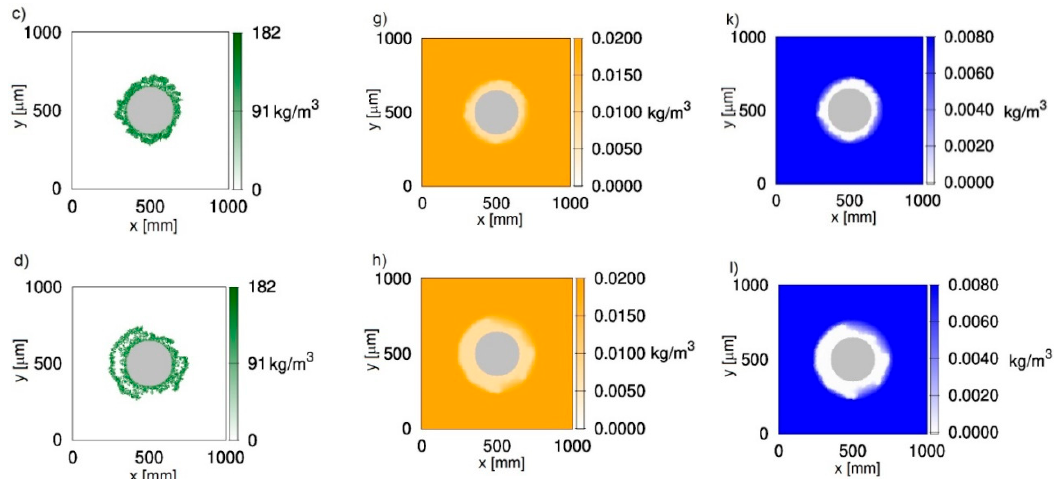
Figure 1. Evolution of the biofilm growth on a particle of radius r z = 150 μ m; left column—biomass density; middle column—phenol concentration; right column—oxygen concentration; successive rows represent time moments: ( a ), ( e ), ( i ) t = 50 h; ( b ), ( f ), ( j ) t = 100 h; ( c ), ( g ), ( k ) t = 150 h; ( d ), ( h ), ( l ) t = 200 h; values on vertical and horizontal axes are expressed in μ m.